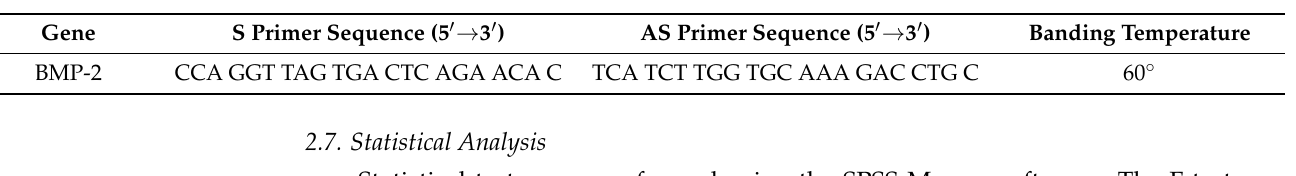
Table 1. Primer used in RT-PCR.